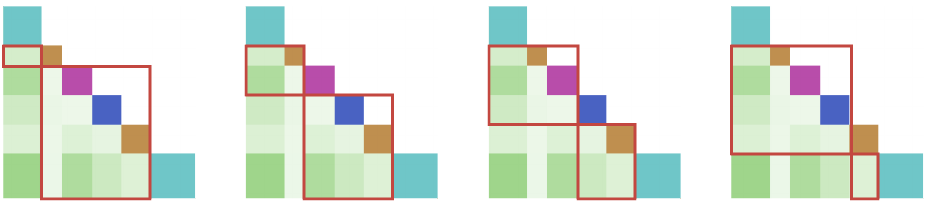
Figure 6. Four small sets of topic segments. Red squares indicate topic segments. Since the way CSseg divides the transcript is by dividing one topic segment into two topic segments, we intend to designate these two adjacent topic segments as a unit, which is called a small set of topic segments.